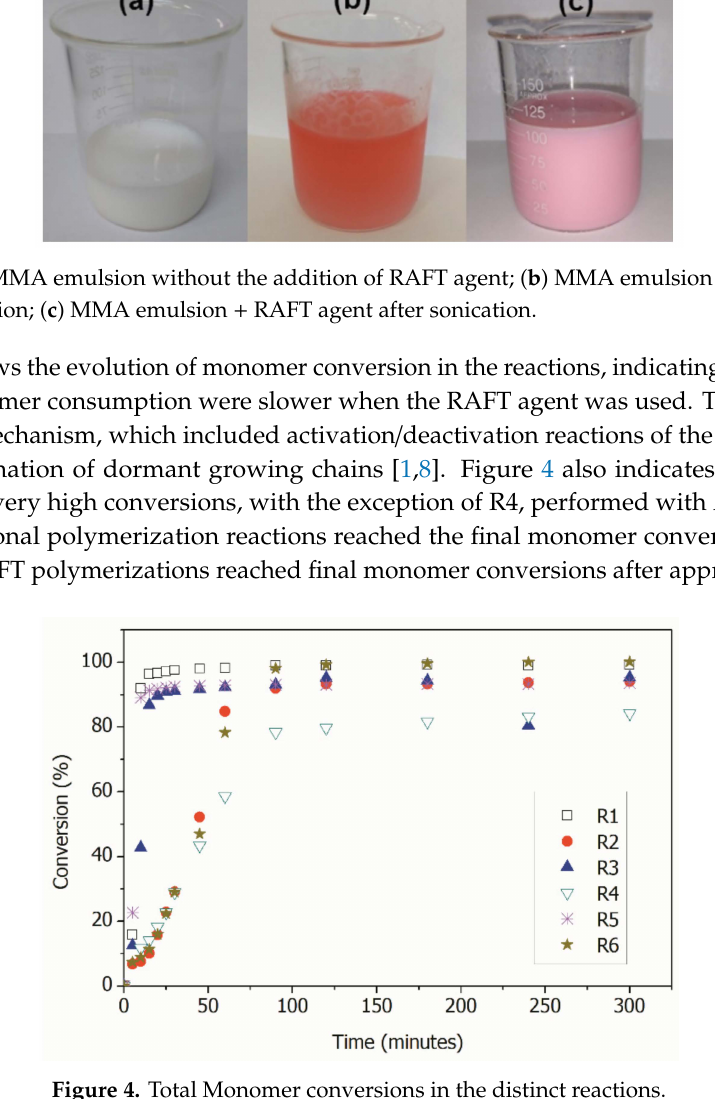
Figure 4. Total Monomer conversions in the distinct